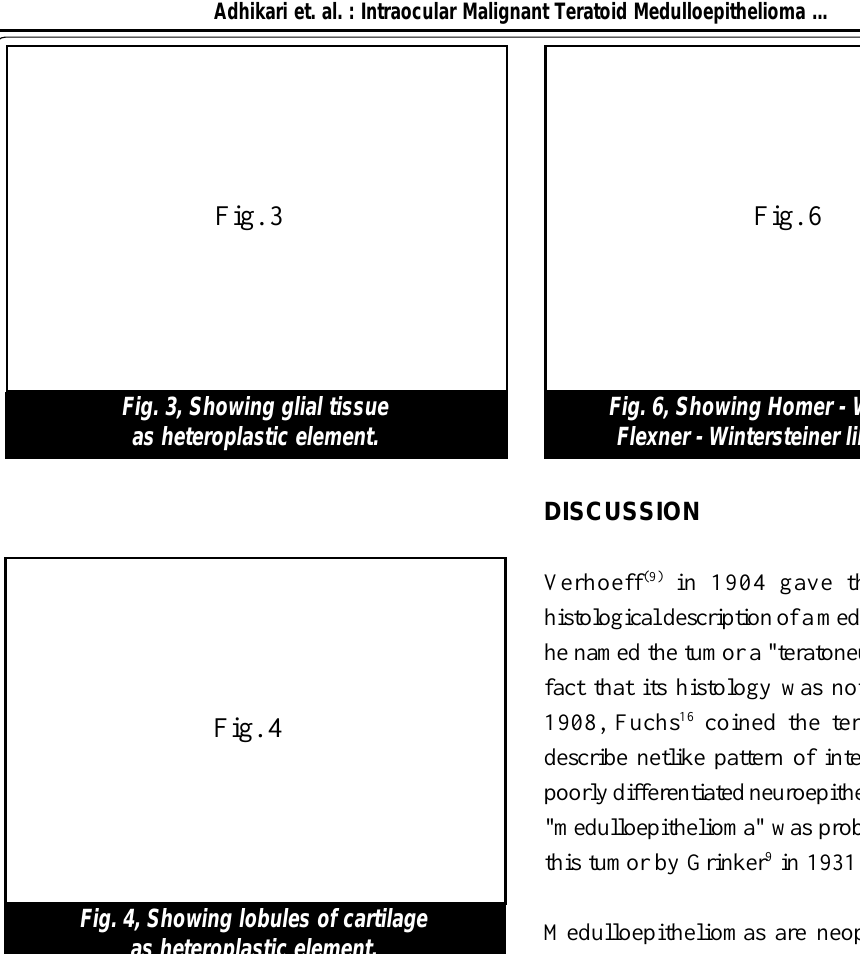
Fig. 4, Showing lobules of cartilage as heteroplastic element.